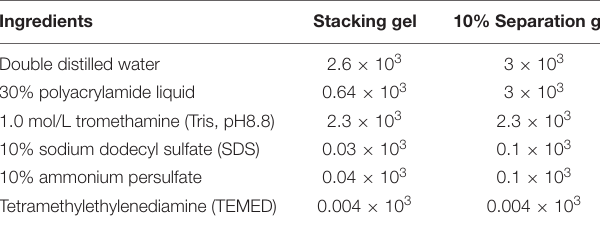
TABLE 1 | Configuration of stacking gel and separation gel. Ingredients